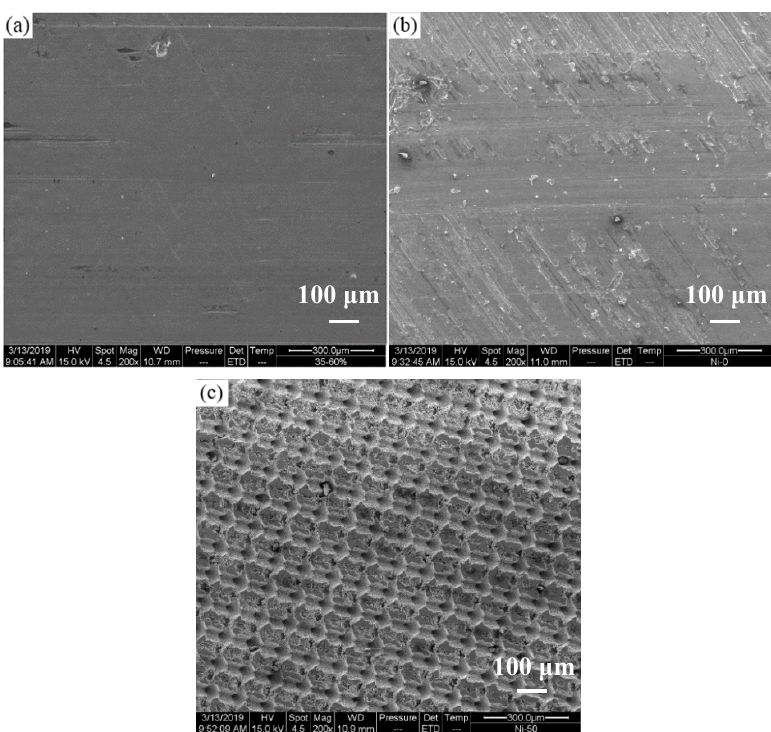
Figure 9. The topographical view of the groove texture of the nickel surface. ( a ) the surface of the as prepared nickel; ( b ) the surface friction morphology of the un-textured nickel; ( c ) the surface friction morphology of the textured nickel with the depth of 50 μ m .